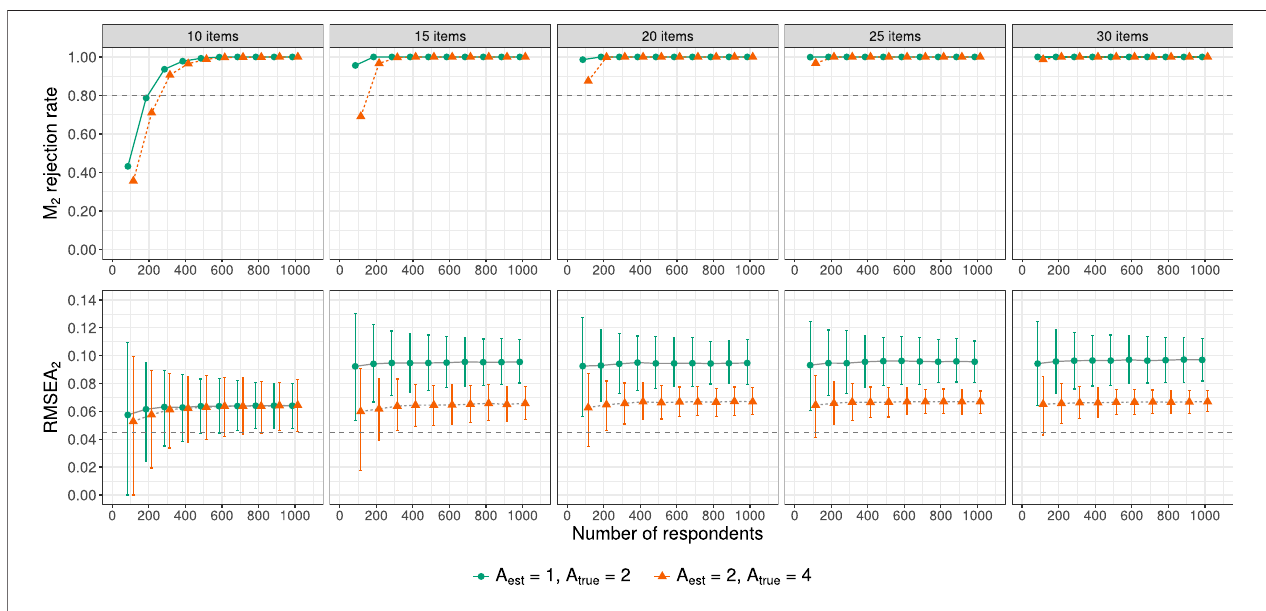
FIGURE 4 | M 2 rejection rates and average RMSEA 2 (with 90% error bars) in the conditions resulting from crossing the number of items I and respondents R for which the estimated model was more coarse-grained than the generating model ( A est < A true ). Horizontal dashed lines indicate M 2 rejection rates of 0.8 (desired power) and RMSEA 2 of 0.045.